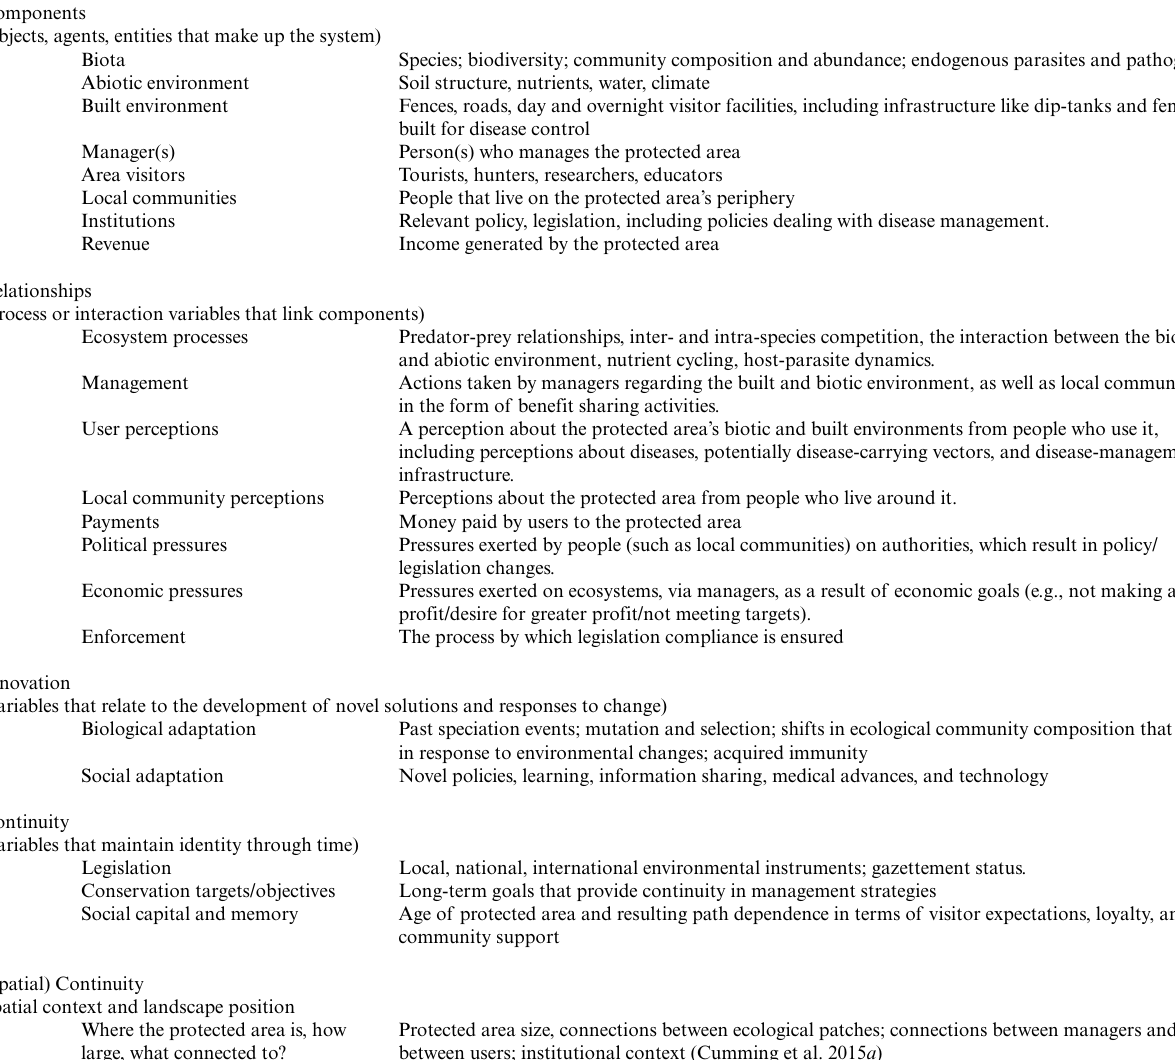
Table 1 . The primary elements of protected area identity as defined and described in the text. Element Attribute